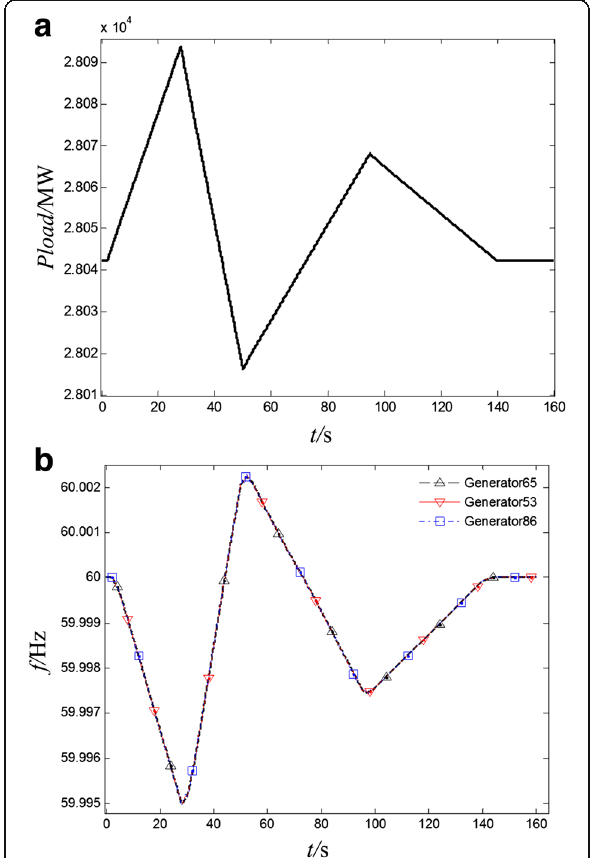
Fig. 8 Load variation example in NPCC model. a System total